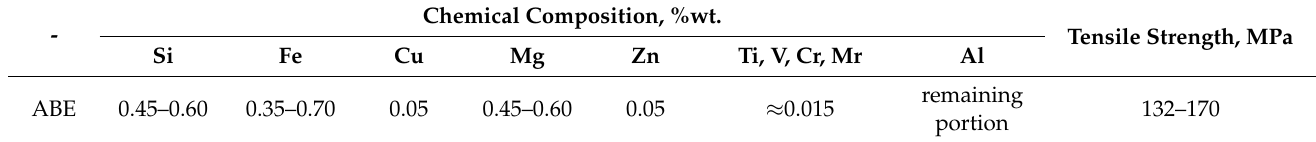
Table 1. Chemical composition of the electrical aluminum alloy of the AVE brand.